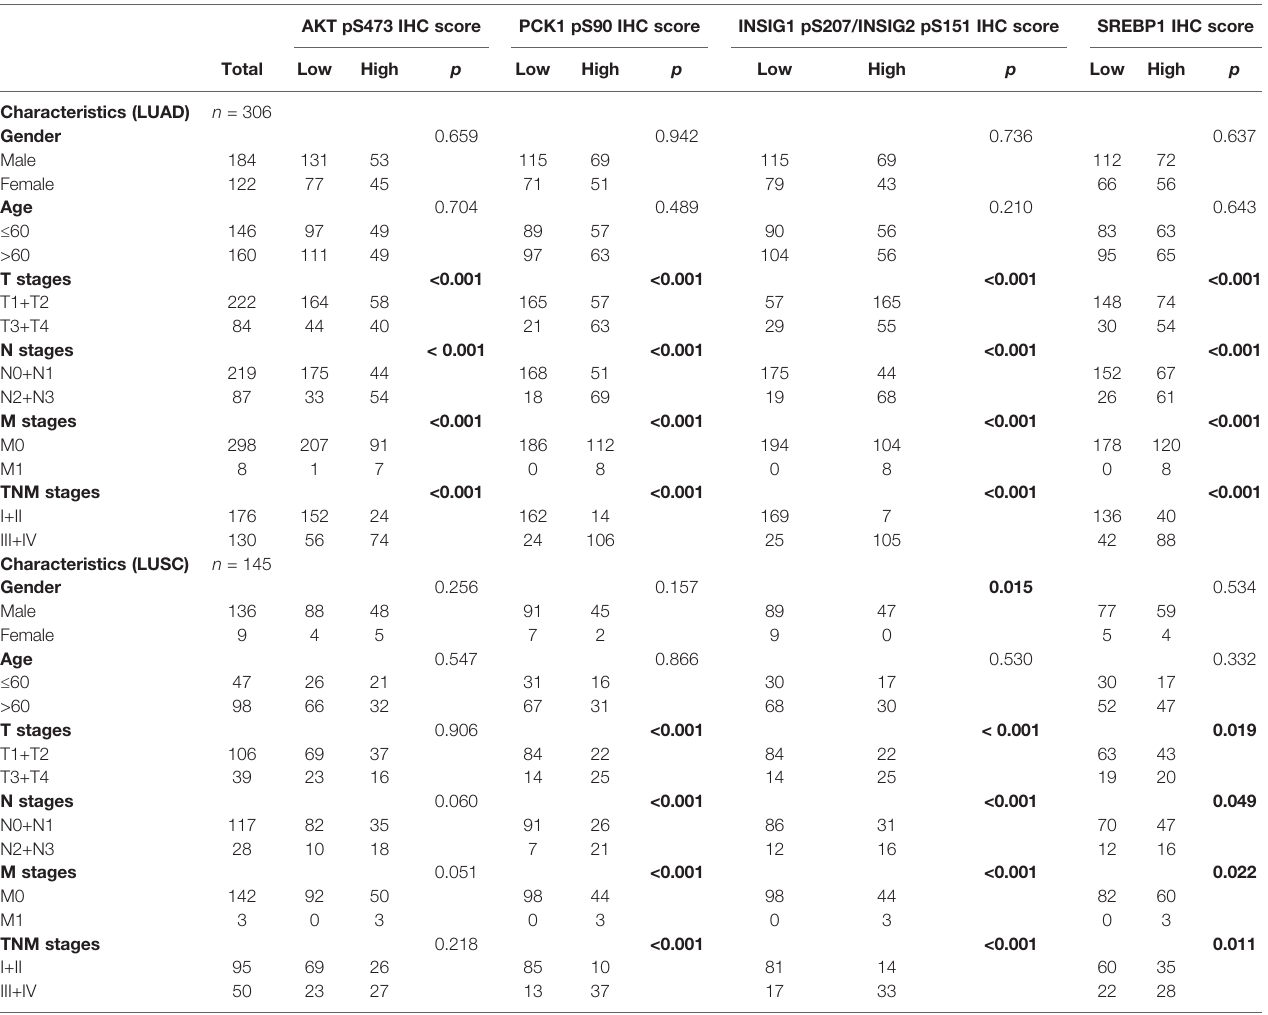
TABLE 1 | Associations of AKT pS473, PCK1 pS90, INSIG1/2 pS207/S151 and SREBP1 with clinicopathologic features in LUAD and